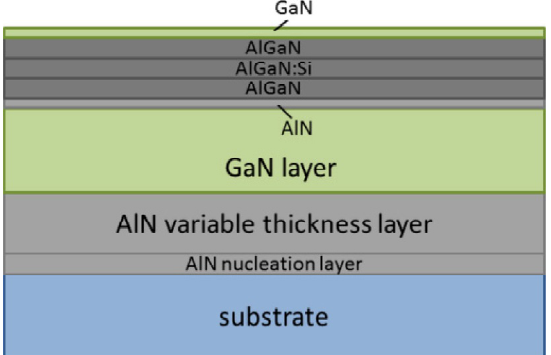
Fig. 1. Schematic picture of the grown HEMT struc- tures on sapphire substrates. It includes thin (a few tens of nm) AlN nucleation layer, AlN layer of vari- able thickness, GaN layer of 800-950 nm in thick- ness, about 1 nm thick AlN capping layer, a stack of AlGaN layers with thicknesses of a few nm each, where the middle layer is doped with Si, and about 3 nm thick GaN capping